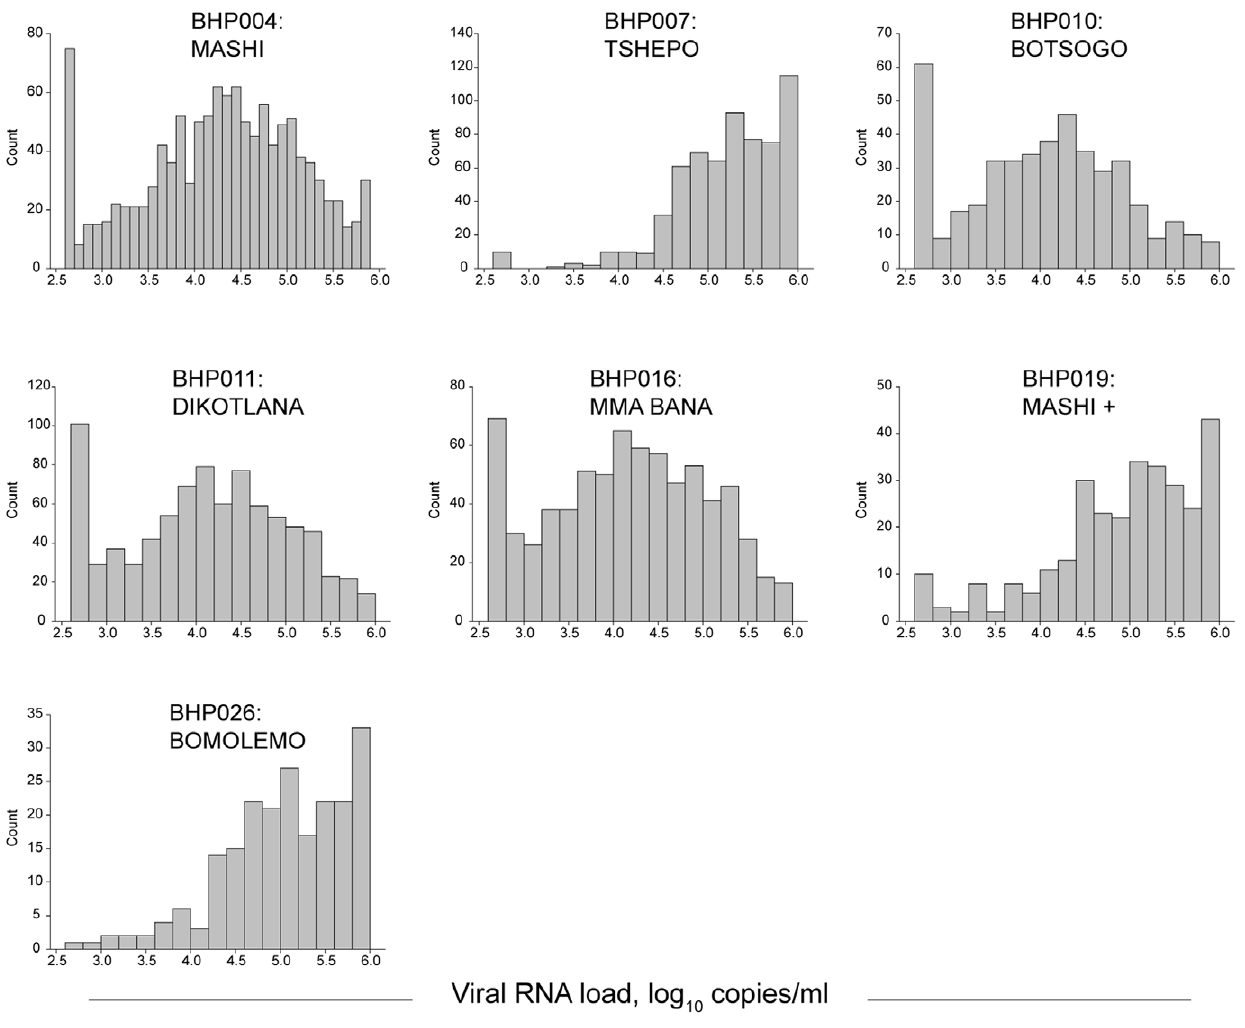
Figure 2. Distribution of HIV-1 RNA levels in seven BHP cohorts (pre-cART baseline data). Y-axis shows the count, and differs between cohorts. X-axis denotes log 10 HIV-1 RNA levels; the scale is uniform for all cohorts. Labels in each graph indicate the BHP study number and the name of the corresponding cohort.